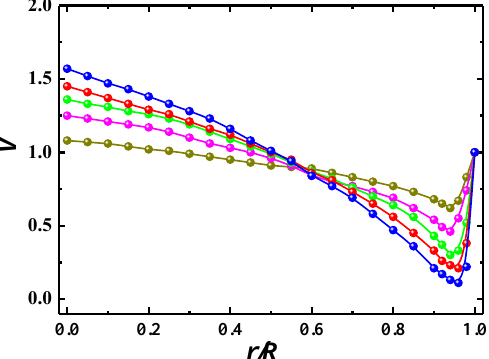
Figure 8. Distribution of particle concentration for different Reynolds numbers at outlet ( λ = 8, L/D = 200). ●: Re = 5000; ●: Re = 10,000; ●: Re = 20,000; ●: Re = 30,000; ●: Re = 40,000.